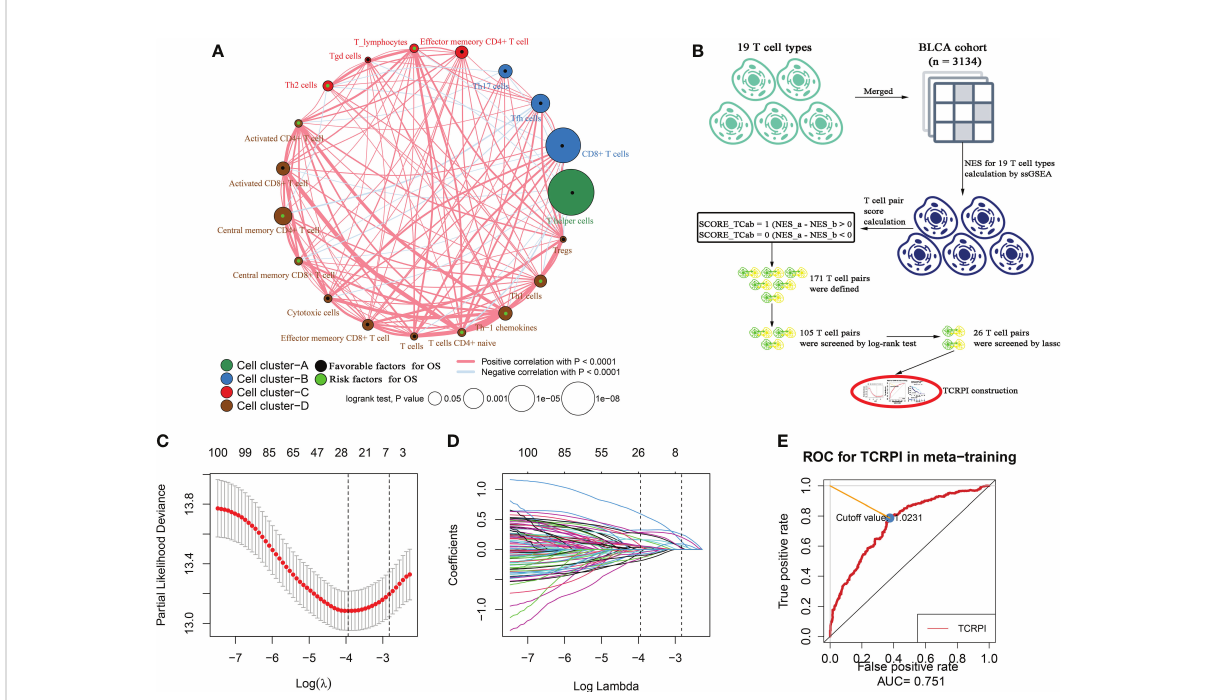
FIGURE 1 Survival landscape of the 19 T-cell types and T-cell related prognostic index (TCRPI) construction. (A) Cellular interaction and survival landscape of the 19 T-cell types. These T-cell types were separated into four clusters, the connection lines between cell types were divided into two kinds: red represents positive correlation, while blue represents negative correlation. The green dot in the T cell represents favorable factors for OS, while the black dot represents risk factors for OS. (B) The fl ow diagram of the TCRPI construction. (C, D) Plot of partial likelihood deviance for the 26 TCPs associated with survival in the training set. (E) Time-dependent ROC curve for TCRPI in the meta-training cohort at 5